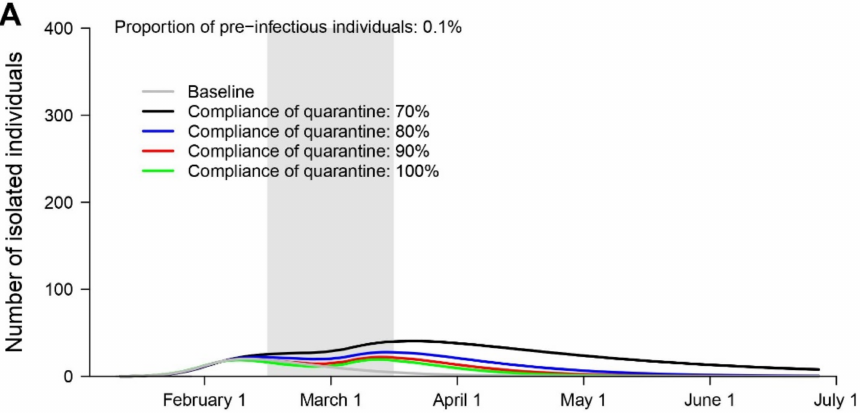
Figure 2. Estimated daily number of individuals with infection in Seoul, South Korea under di ff erent scenarios regarding the proportion of pre-infectious individuals: 0.1% ( A ), 0.2% ( B ), and 1% ( C ), based on di ff erent compliance rates with home-quarantine (gray: baseline, black: 70%, blue: 80%, red: 90%, green: 100%). Shaded gray bars represent the period of arrival of the international students from China, the country with the risk of 2019 novel coronavirus on February